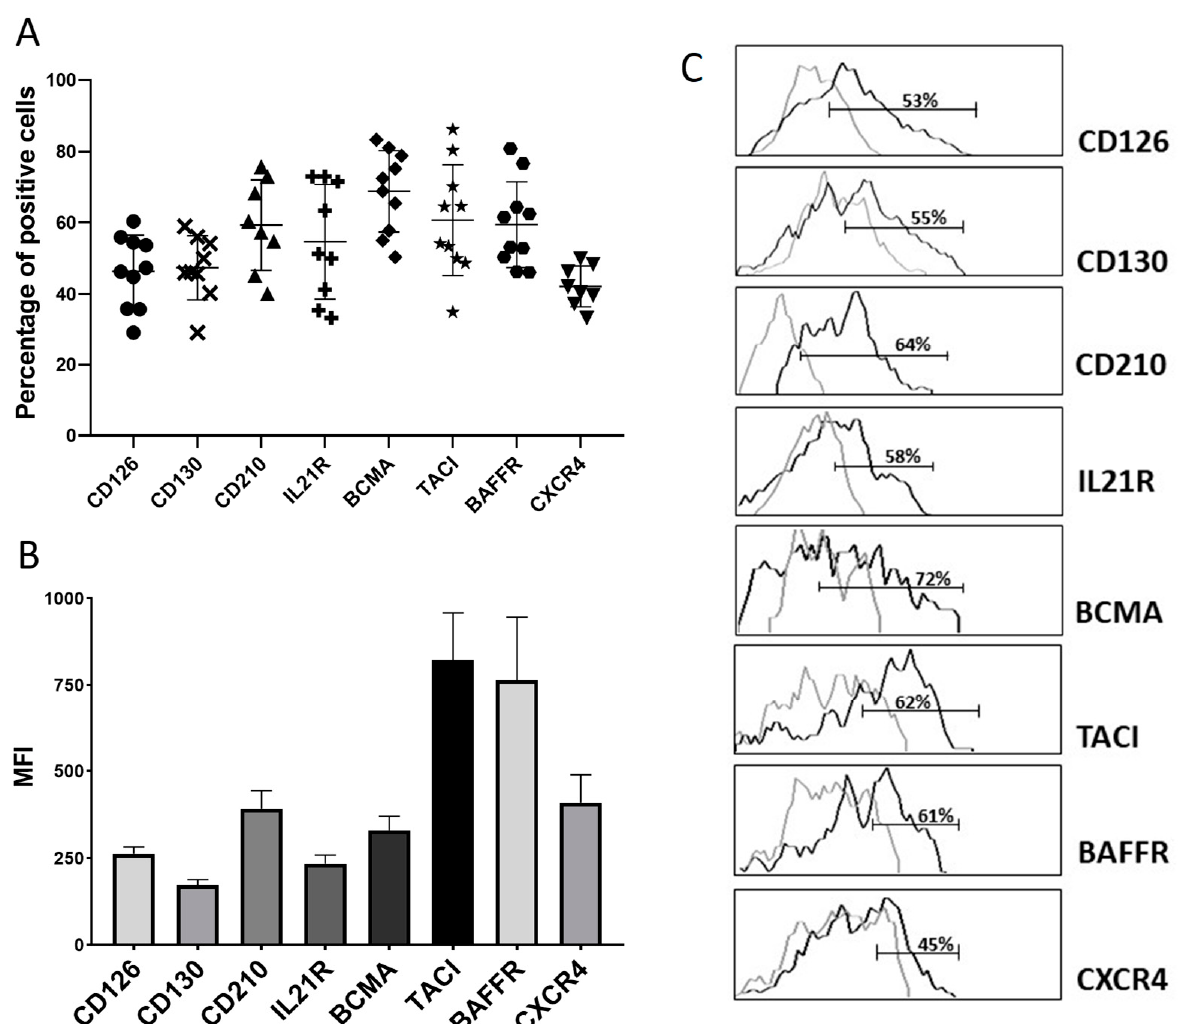
Figure 2. Cytokine and chemokine receptors expressed in blood PBs after immunisation. The percentage ( A ) and mean fluorescence intensity ( B ) of CD126, CD130, CD210, IL-21R, BCMA, TACI, BAFFR, and CXCR4 expression were determined by flow cytometry on CD19 low CD38 high PB from the enriched B-cell fraction in vaccinated individuals seven days after the second dose of the vaccine (n = 10). The results are expressed as the mean ± SEM of 10 independent experiments. The mean percentage of positive PBs for each marker is: CD126: 46.4%; CD130: 47.4%; CD210: 59.3%; IL21R: 54.7%; BCMA: 68.8%; TACI: 60.7%; BAFFR: 59.4%; CXCR4: 42.1%. ( C ). Representative histograms are shown. Isotype controls are shown as grey lines. MFI: mean fluorescent intensity; PB: plasmablasts; SEM: standard error mean.